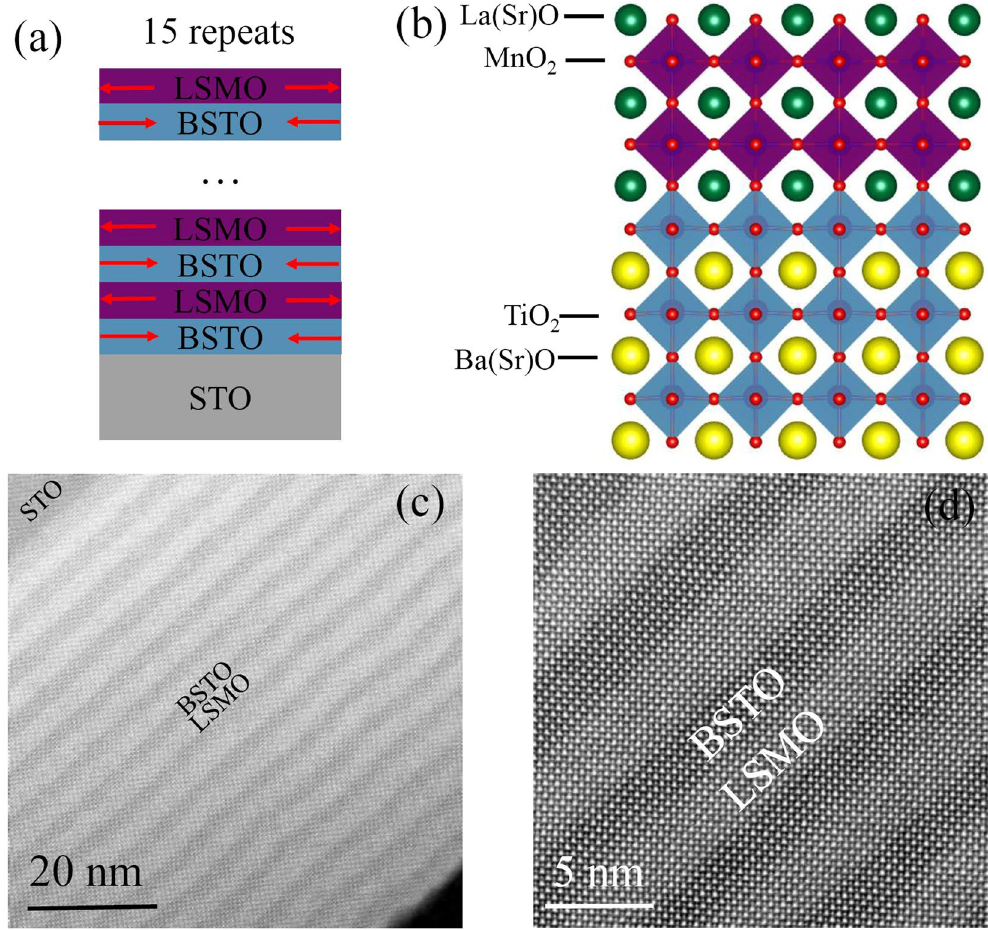
Figure 2. The atomic structure of SL L7B6 grown on STO substrate characterized by STEM. ( a ) The stacking sequence of the LSMO/BSTO SL, showing a single supercell that is repeated the indicated number of times. The red arrows showing the tensile and compress stress along in-plane directions. ( b ) Structure model of LSMO/ BSTO SL. ( c ) A low-magnification cross-sectional HAADF-STEM image exhibiting the entire LSMO and BSTO bands and the STO substrate along the [100] axis of STO. ( d ) High-resolution HAADF-STEM image clearly showing the 7-u.c.-thick LSMO band and 6-u.c.-thick BSTO band. Sharp interfaces and lateral coherency also clearly exhibiting. The lighter bands are LSMO, the darker bands